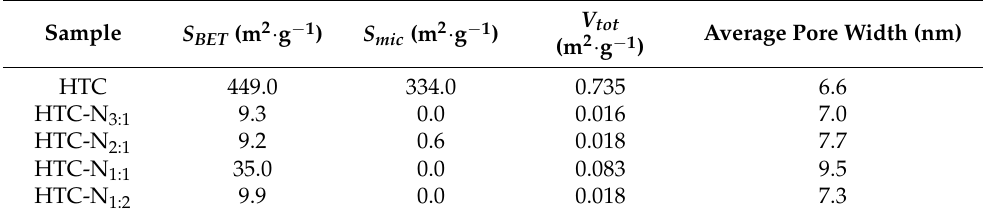
Table 1. Textural and structural properties of the carbon supports.